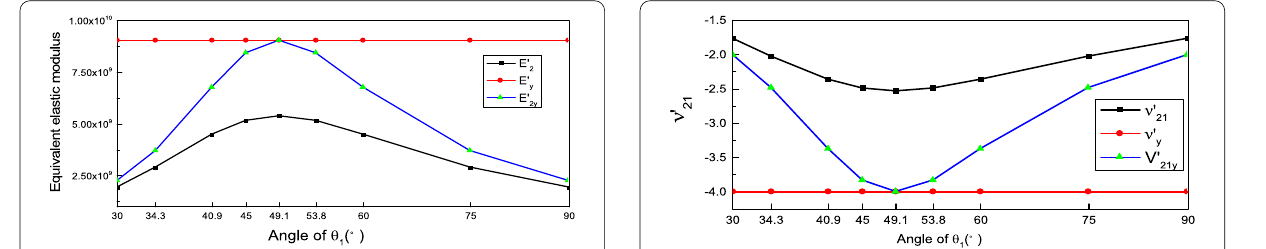
Figure 17 Poisson’s ratio with varying θ 1 angle in the σ 2 direction